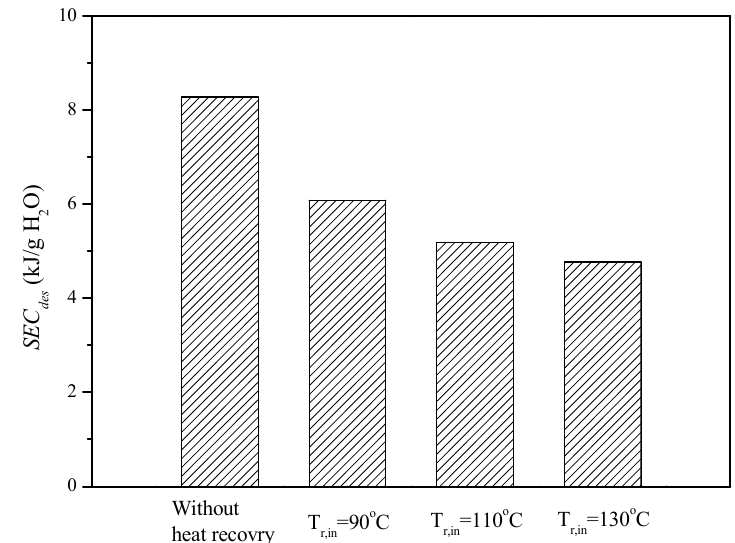
Figure 9. The specific energy consumptions, kJ/g H 2 O, of the heat pipe-based desiccant device at various heat recovery temperatures and without employing waste heat recovery.